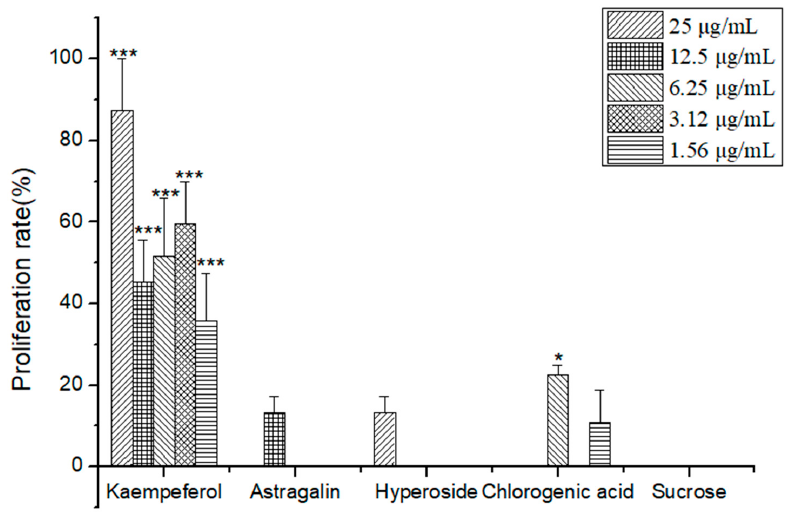
Figure 5. The effects of active compound in TSZE-EA-G6 on the proliferation of NSCs. Different from control, * p < 0.05, *** p < 0.001.